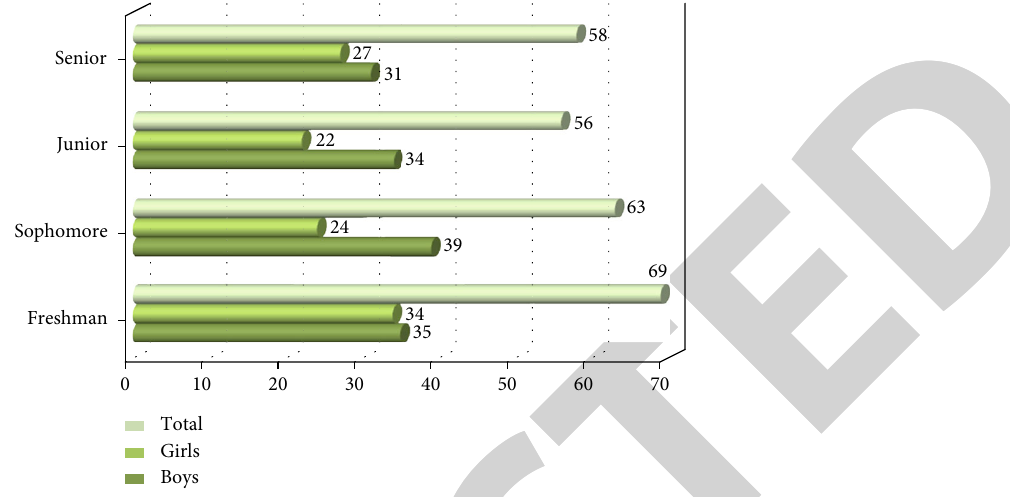
Figure 2: Composition of students participating in the questionnaire. Table 3: Average mobile terminal usage by students.